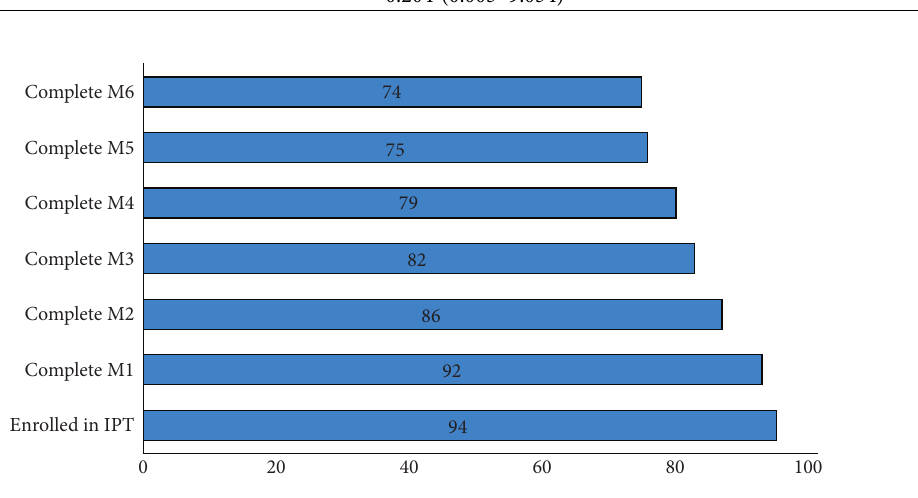
Figure 2: The number of retained children under the age of 5 at each month of INH prophylaxis treatment in Addis Ababa. ∗ Complete M, those children who complete the monthly